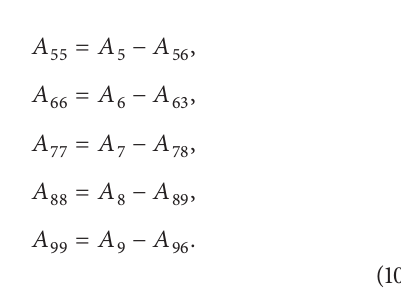
Figure 1: Illustration of multiple rooms.